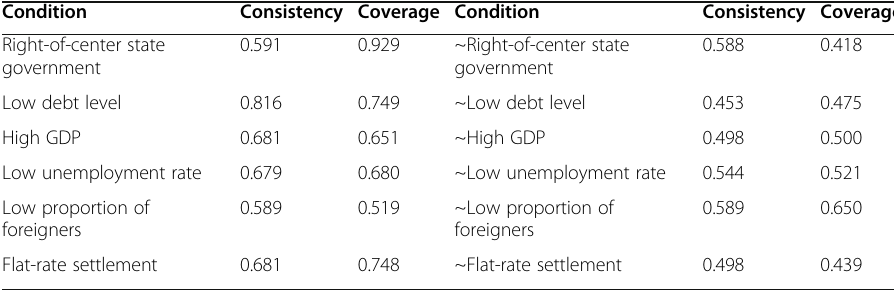
Table 3 Test for the necessary conditions for the “ non-commissioning of health insurance providers ” outcome